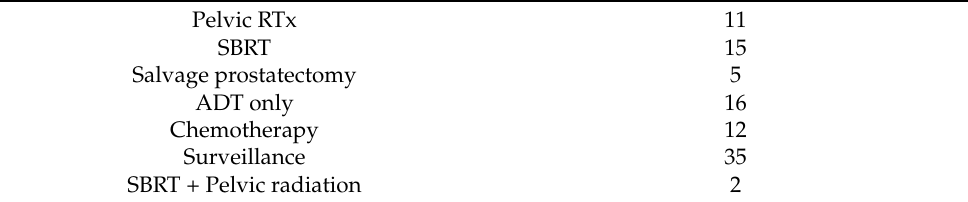
Table 4. Clinical decisions made using PSMA PET-CT results.